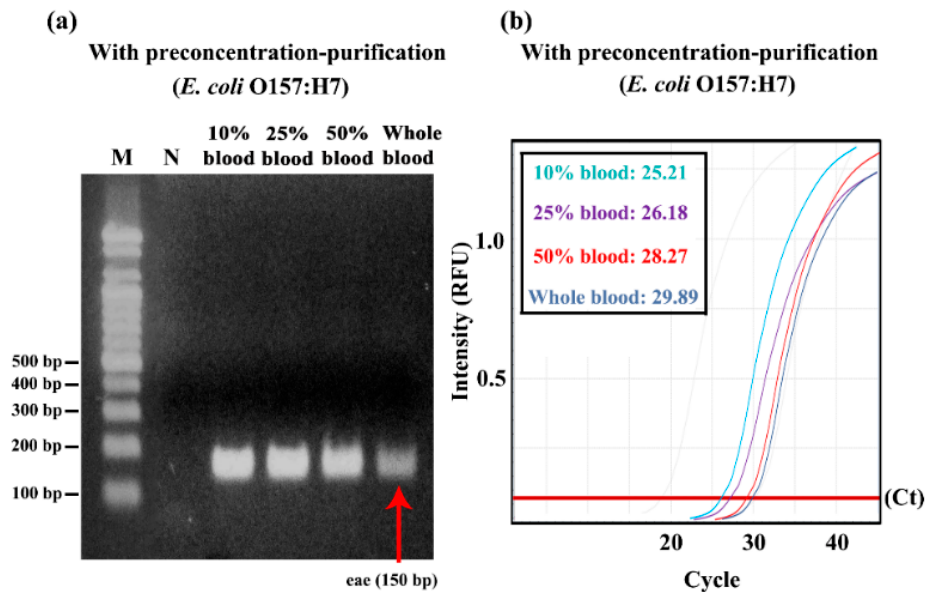
Figure 6. Confirmation of effect of dilution factor of blood on preconcentrating and gDNA purification efficiency with E. coli O157:H7 using PCR with gel electrophoresis and qPCR; ( a ) Gel electrophoresis of PCR products ( eae gene) from different blood dilutions (10, 25, 50, and blood) containing 10 5 CFU/mL of E. coli O157:H7 after bacterial preconcentration and DNA purification; ( b ) qPCR result.